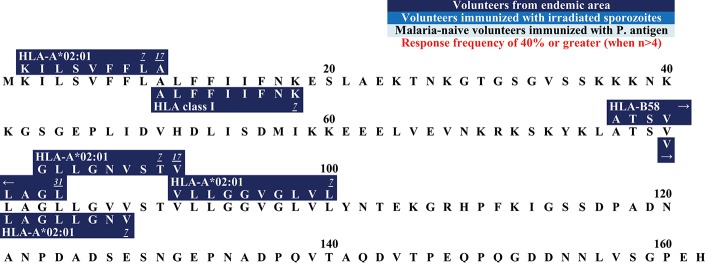
Epitope map of EXP1.